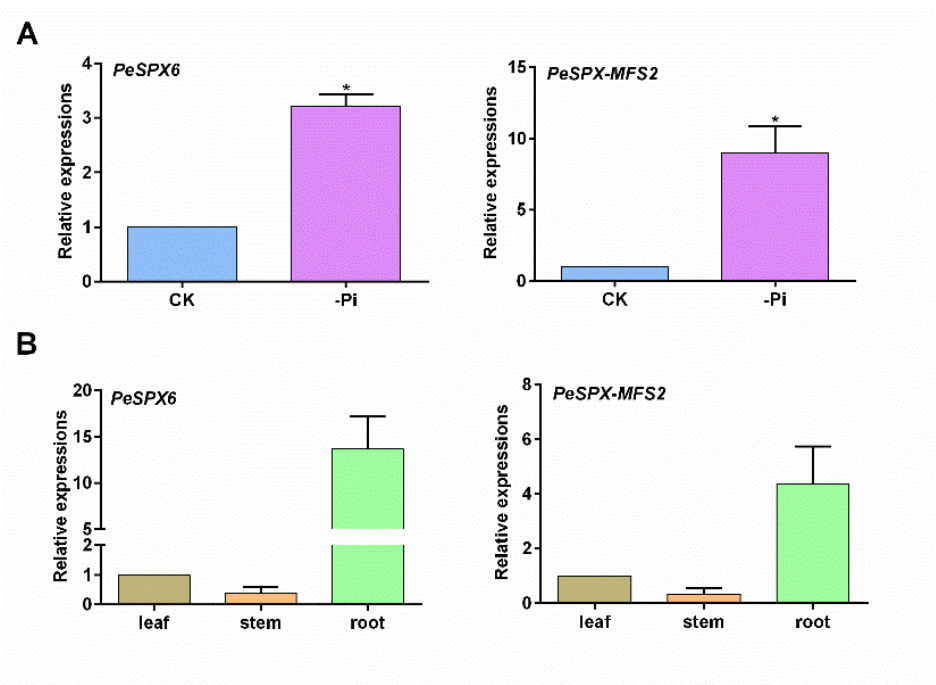
Figure 5. Expression patterns of PeSPX6 and PeSPX-MFS2 in Phyllostachys edulis . ( A ) Quantitative RT-PCR analysis of PeSPX6 and PeSPX-MFS2 exposed to low phosphorus in roots. ( B ) Quantitative RT-PCR analysis of PeSPX6 and PeSPX-MFS2 expression in various tissues (leaf, stem, and root tissues). Error bars in ( A , B ) indicate SD ( n = 3). The asterisks in ( A , B ) show a significant difference compared to the control using the unpaired Student’s t test (* p < 0.05).